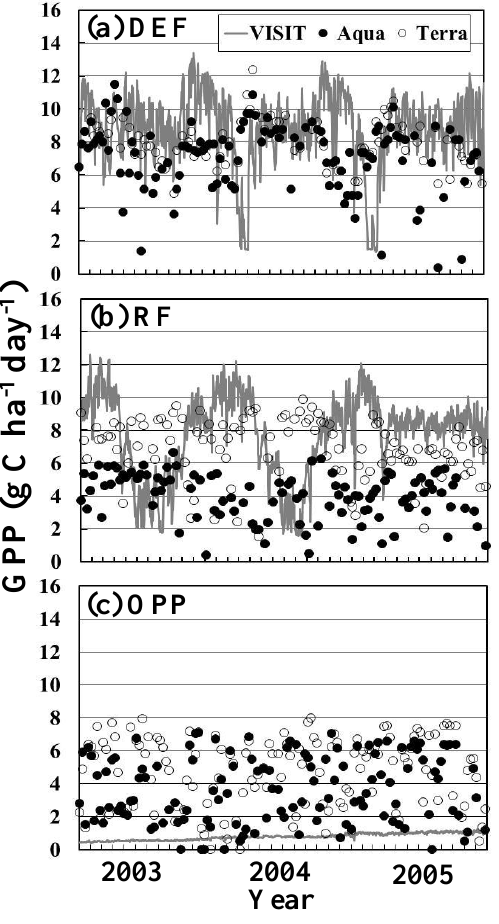
Fig. 9. Seasonal variations in gross primary production (GPP) based on satellite observations (Aqua and Terra MODIS values) and the VISIT model simulation in (a) the dry evergreen forest (DEF) in Thailand, and (b) the rainforest (RF) in Malaysia, and (c) the oil palm plantation (OPP) in Malaysia. Because oil palm seedlings were replanted in 2002 for second rotation in OPP, the disturbance event from forest to oil palm plantation in the VISIT model was set for